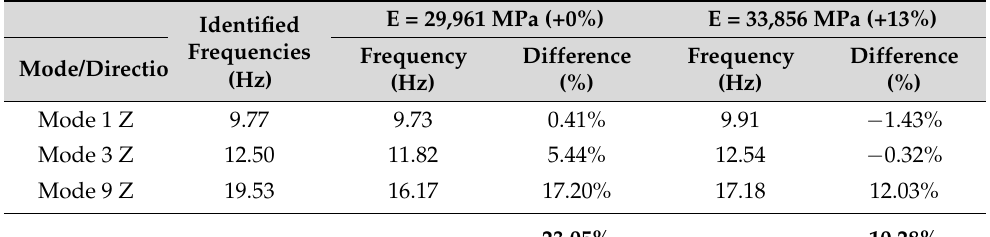
Table 10. Comparison between frequencies of the updated model and identified ones.